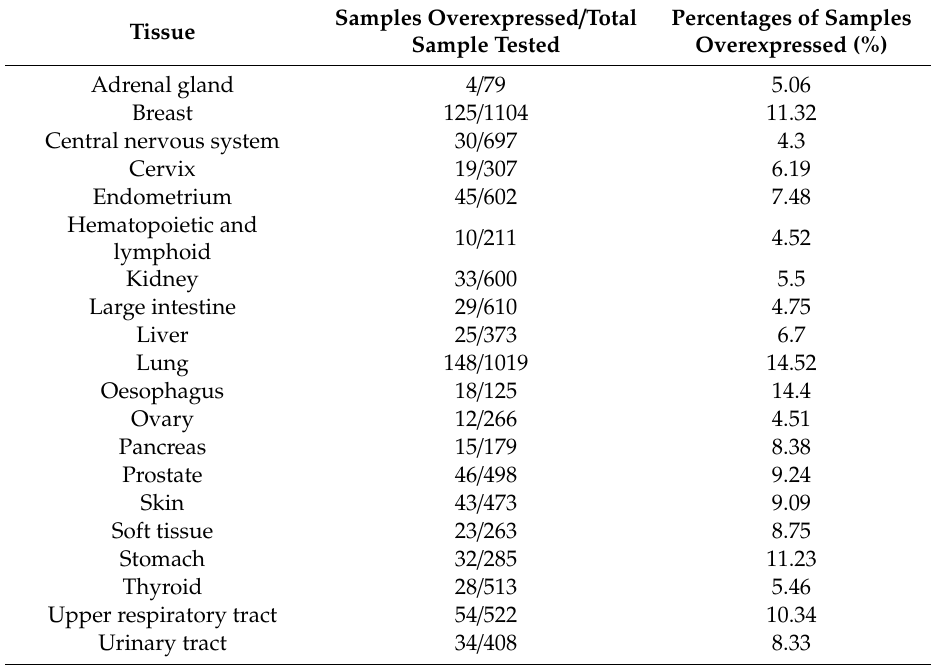
Table 3. ANLN overexpression in the di ff erent tissue types